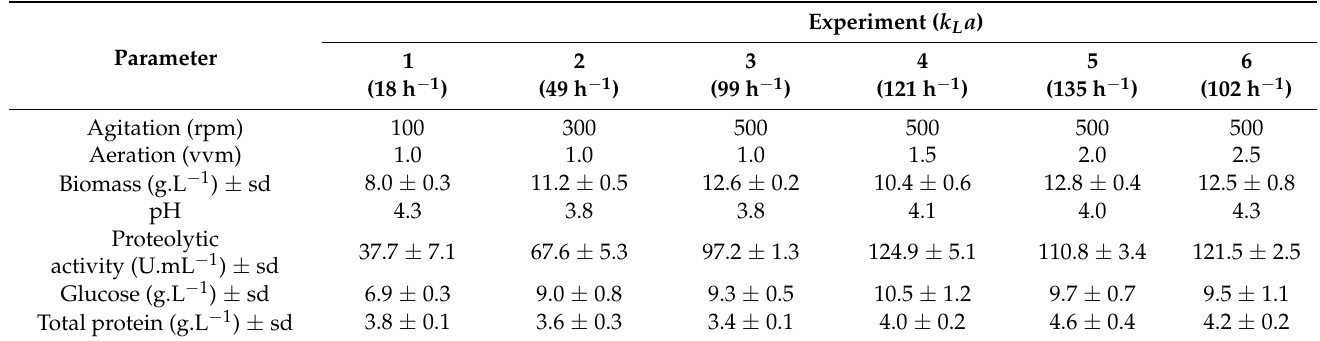
Table 2. Experimental values of biomass concentration, glucose, total proteins, pH, and proteolytic activity of R. mucilaginosa CBMAI 1528 cultivation in bioreactor for 72 h.